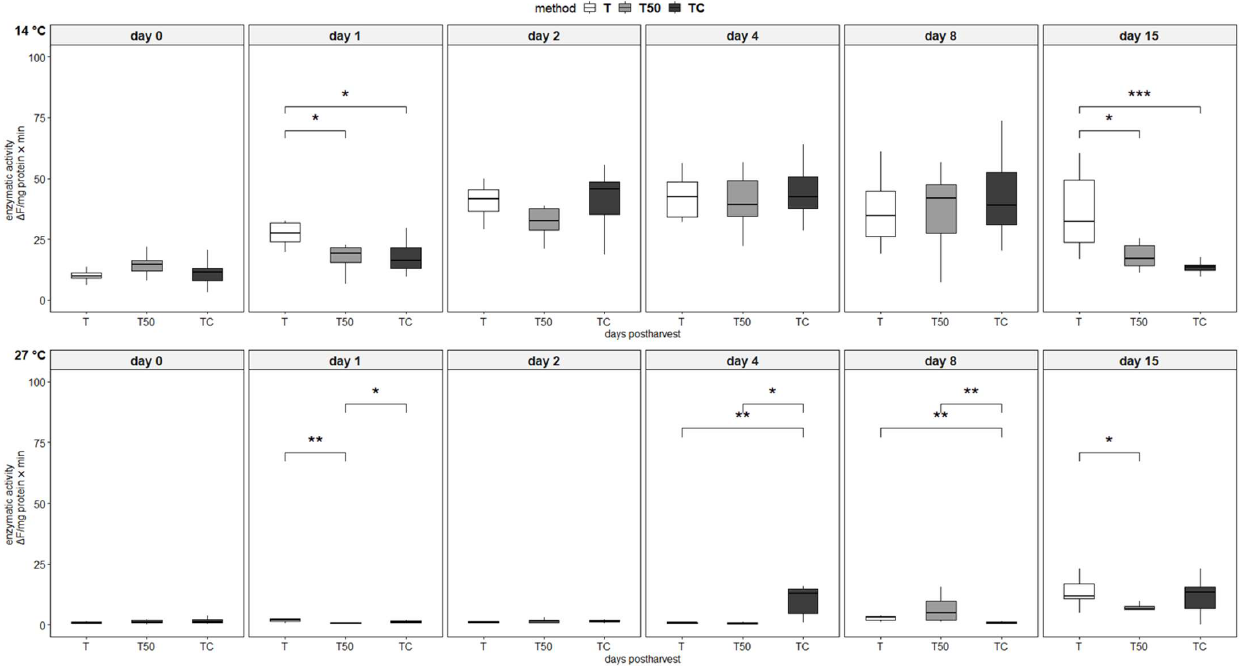
Figure 8. Cathepsin B activity in all tested slaughter and storage conditions. T: control group, slaughter and storage in ice flakes; T50: slaughter and storage in 1:1 slurry ice to ice flakes; TC: slaughter in slurry ice, storage in ice flakes. Enzymatic activity was expressed as fluorescence unit (FLU) change per minute per mg protein ( ∆ F). Superscripts: statistically significant differences between treatments on each sampling day (***: p < 0.001, ** p < 0.01, *: p <